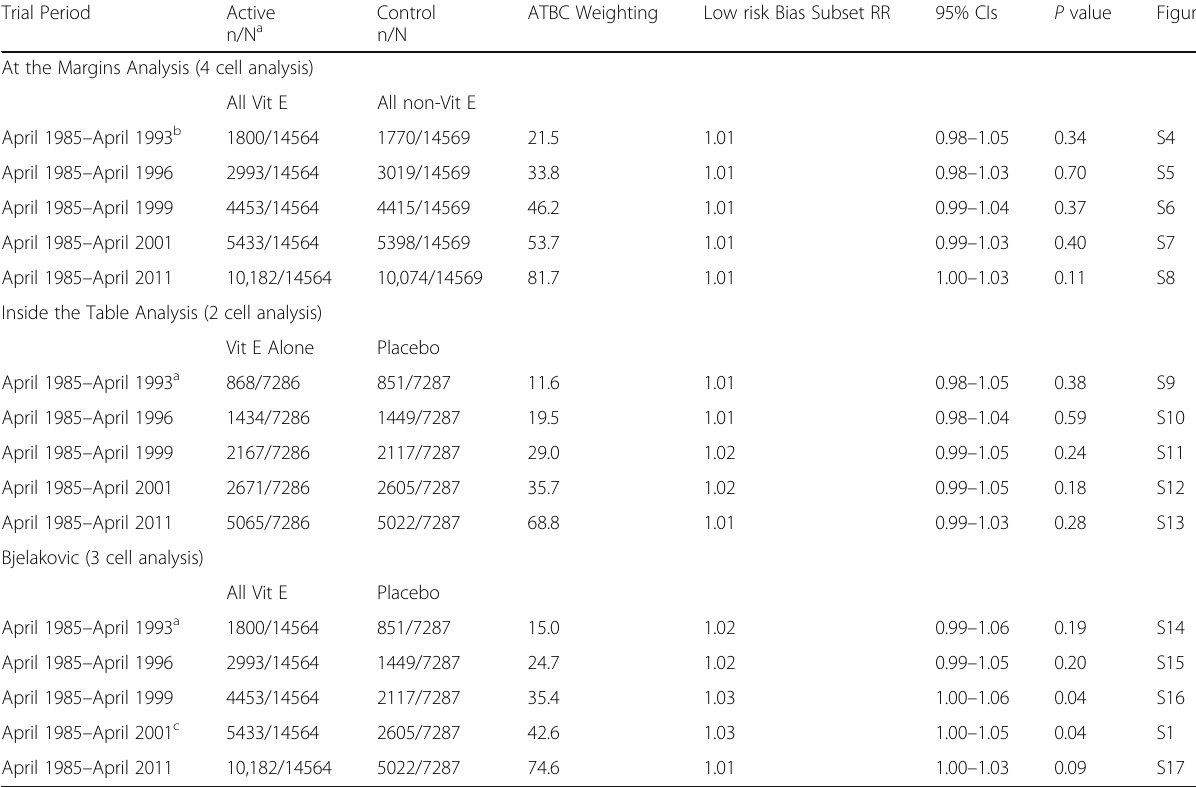
Table 3 Risk ratio (RR) according to ATBC study period analysed using three methods - ‘ inside the table ’ (2 cell), ‘ at the margins ’ (4 cell) and Bjelakovic (3 cell) - utilising the Bjelakovic low risk of bias dataset (A11) Trial Period Active Control ATBC Weighting Low risk Bias Subset RR n/N a n/N At the Margins Analysis (4 cell analysis) All Vit E All non-Vit